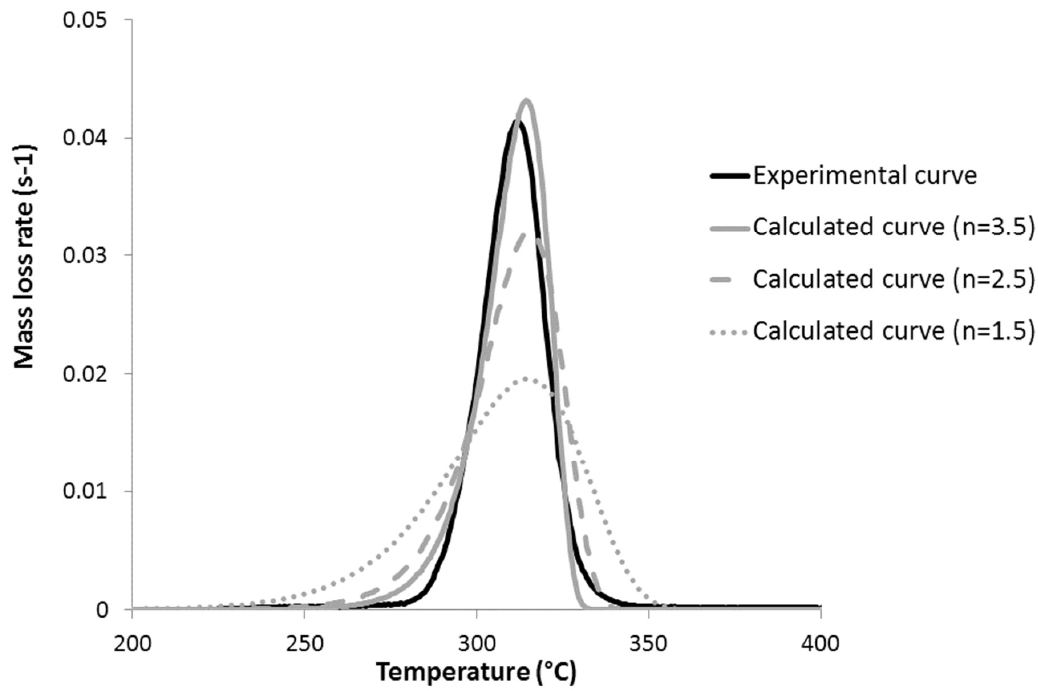
Figure 12 – Experimental and calculated mass loss rate curves at 1 K/s (PCFC) with different values for Figure 12. Experimental and calculated mass loss rate curves at 1 K/s (in a PCFC) with different values for n for n for PHB